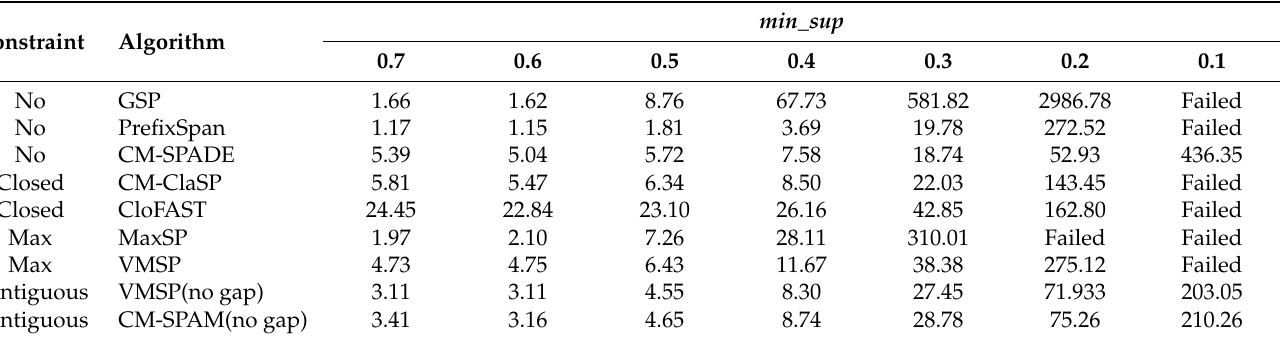
Table 3. Runtime (s) of Algorithms with different minimum support ( min _ sup ) categorized by their constraints.